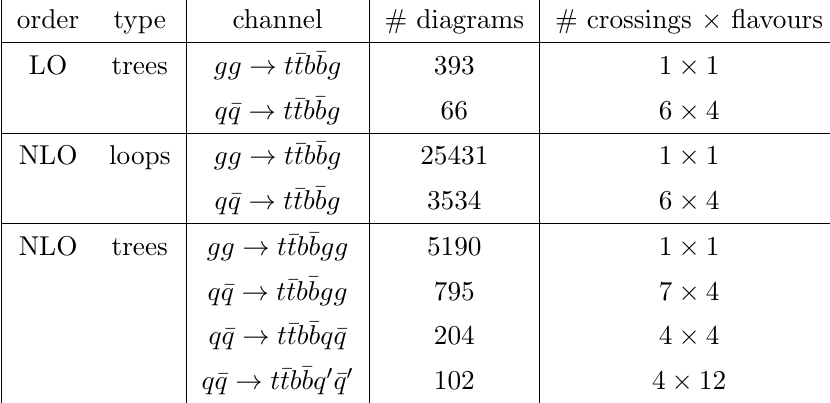
t (cid:22) tb (cid:22) bj at NLO. For each class ! = q 0 . In 6 4 is the